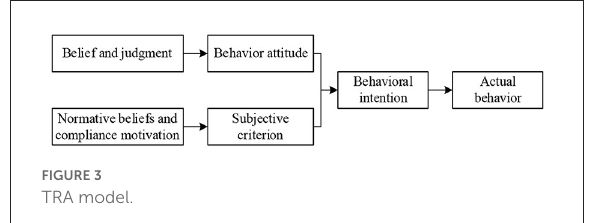
FIGURE3 TRA model.